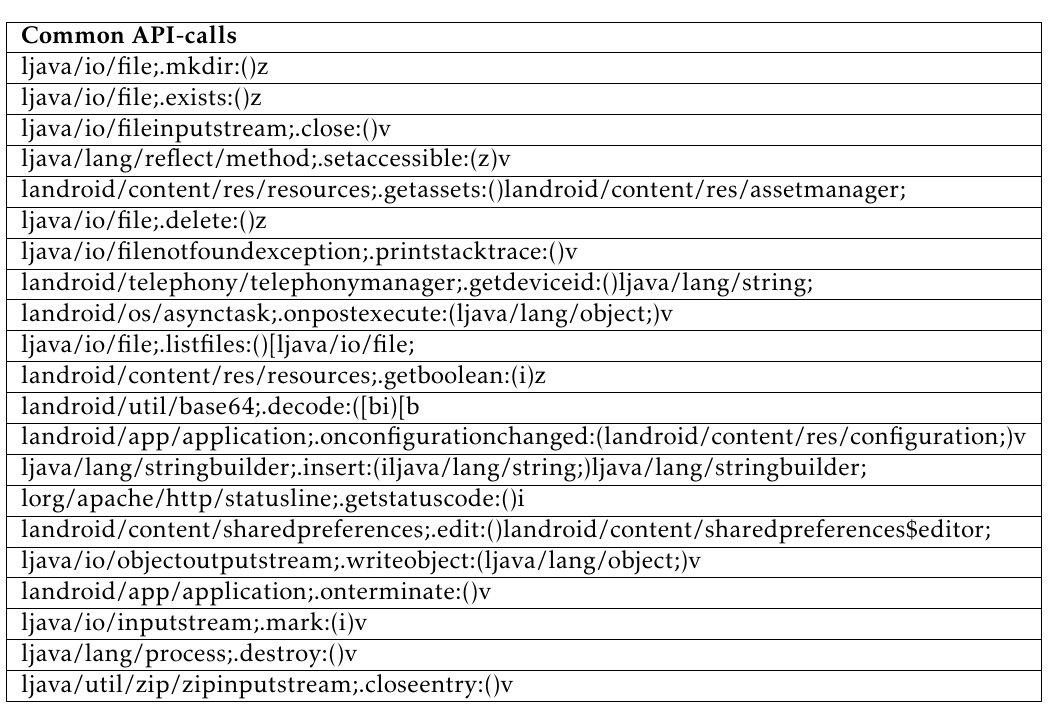
Table 5. Common API-calls from the two models